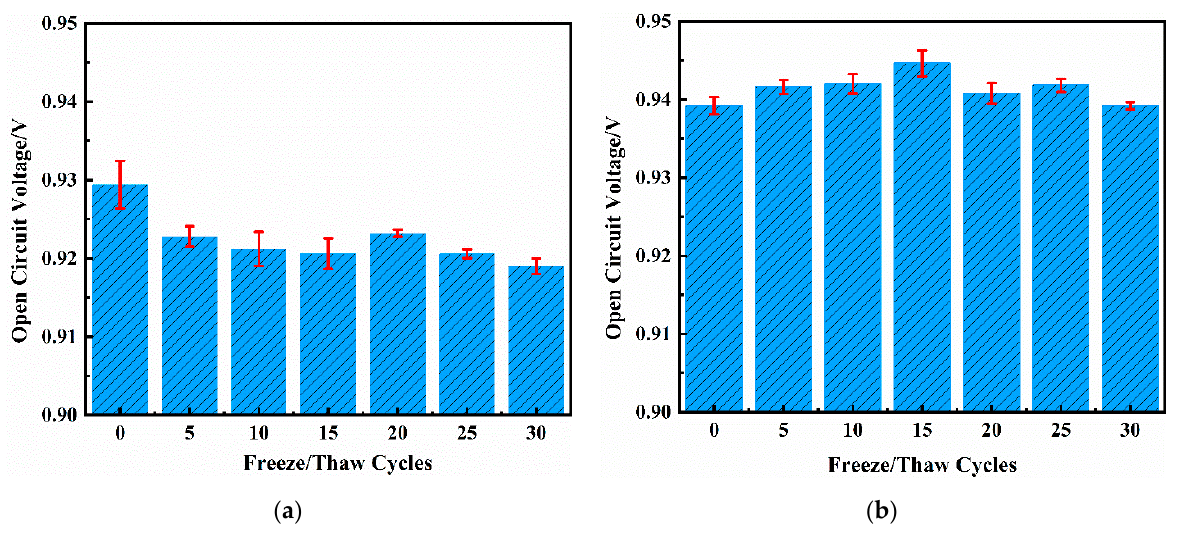
Figure 4. Effect of freeze/thaw cycles on the open circuit voltage of the two cells: ( a ) cell-1; ( b ) cell-4.